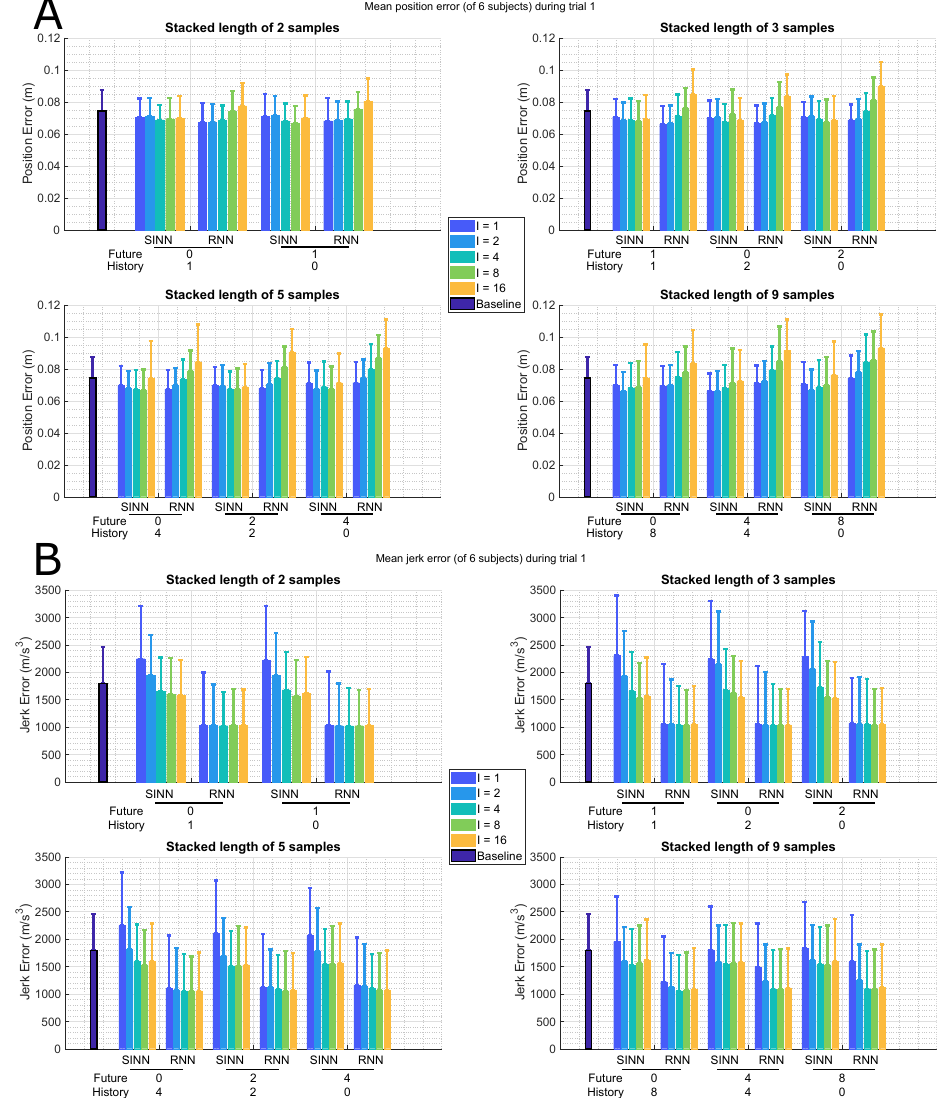
Figure 4. Bar plots of the full-body mean (of 6 subjects) joint position ( A ) and jerk ( B ) error for the shallow (SINN, left bars for each configuration) and deep (RNN, right bars for each configuration) learning approaches during a gait trial (1 in Table 1), standard deviation over the various subjects is displayed by whiskers. The different time windows are presented on the x -axis, where the number of past ( P ) and future ( F ) poses are shown. The interval ( I ) between input poses are marked by the different colours, where the number of samples between input poses is shown. For comparison, the mean joint position error ( A ) for using only the current pose as input (SINN approach) is 0.07 ( ± 0.01) m. For comparison, the baseline using only the current pose as input) mean joint position ( A ) and jerk ( B ) errors are shown as the dark blue bars on the